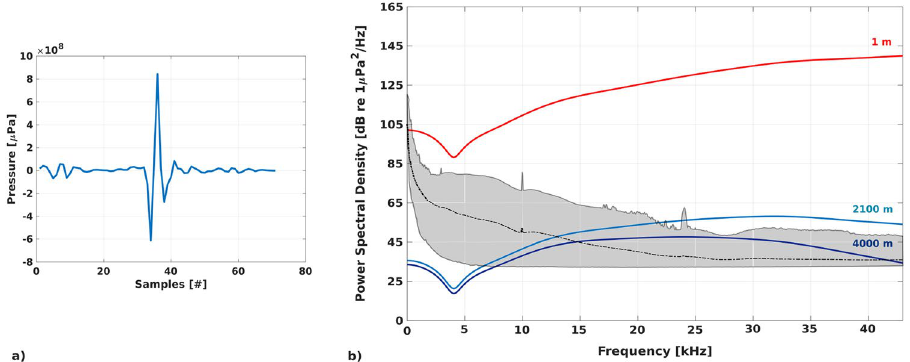
Figure 8. Detection range of the O ν DE station. ( a ) Waveform of a click emitted by a striped dolphin ( Stenella coeruleoalba ) recorded (fs: 300 kHz) during a boat-based acoustic survey conducted in the Central Mediterranean Sea. ( b ) Transmission Loss (TL) model of the click to recognize the variation of Power Spectral Density (PSD, dB re 1 µ Pa/ √ Hz) during signal propagation. In red, PSD of the signal as source spectral density; in light blue, PSD of the click after 2,100 m of propagation; in blue, PSD of the click after 4,000 m of propagation. The grey area represents upper and lower limits of average PSDs calculated for the O ν DE dataset recorded using channel H3. The black curve is the average calculated over all